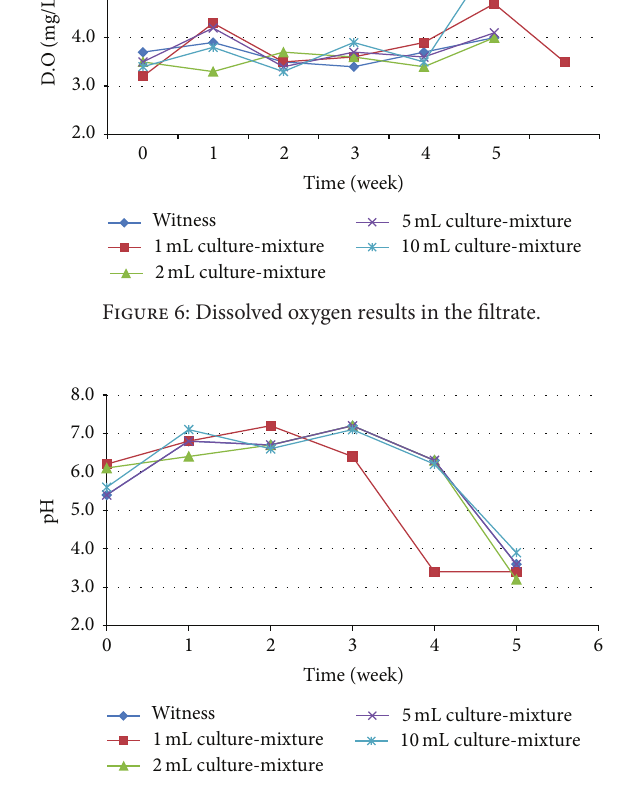
Figure 7: pH results in the